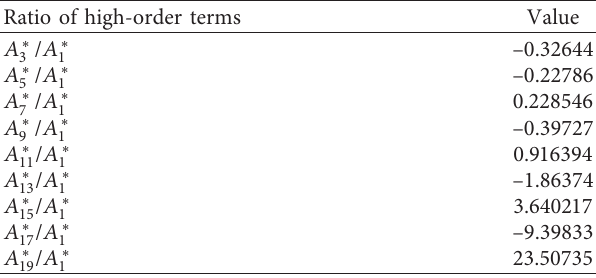
Table 4: Dimensionless coefficient ratio ( A ∗ relative crack length ratio α � 0.4.